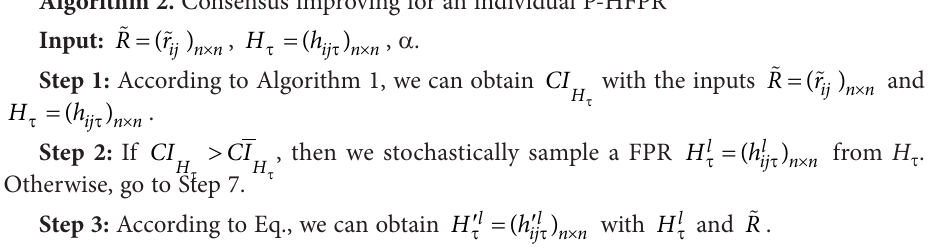
Algorithm 2. Consensus improving for an individual P-HFPR